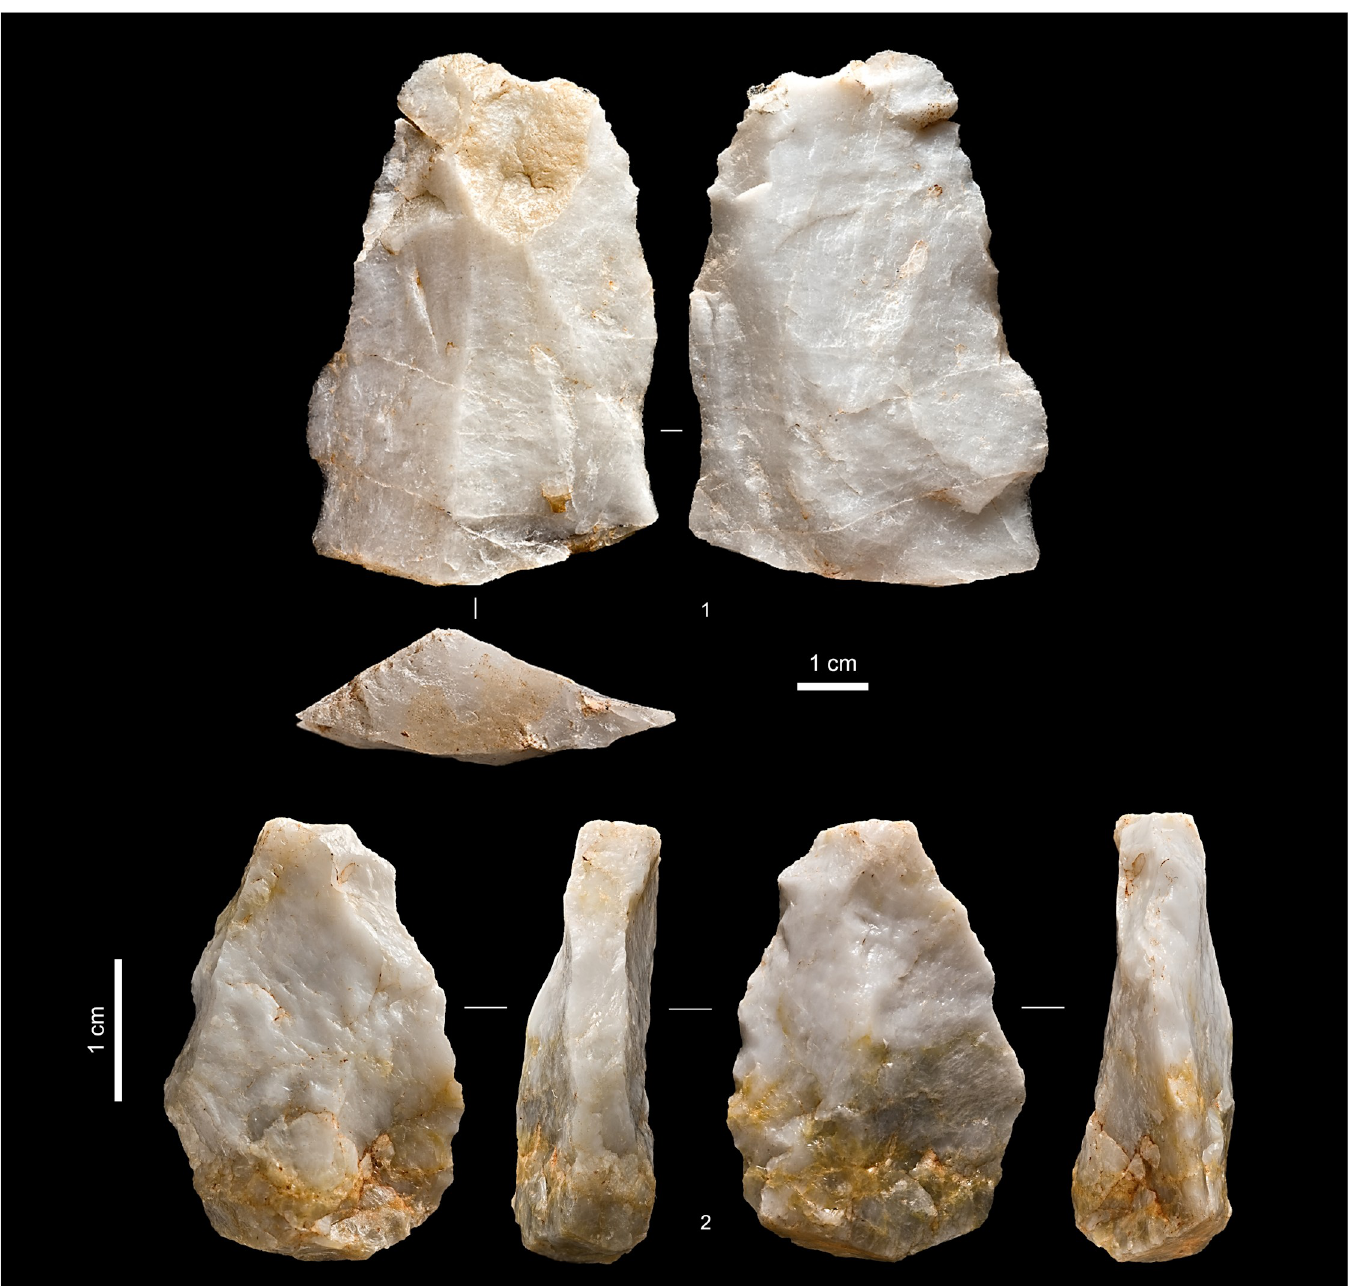
Fig 11. Quartz tools from layers K-L. 1. Sidescraper (bilateral, inverse retouch; O13-361, surface of layer L). 2. Sidescraper (bilateral, alternate retouch; P11sc852-3, base of layer K).